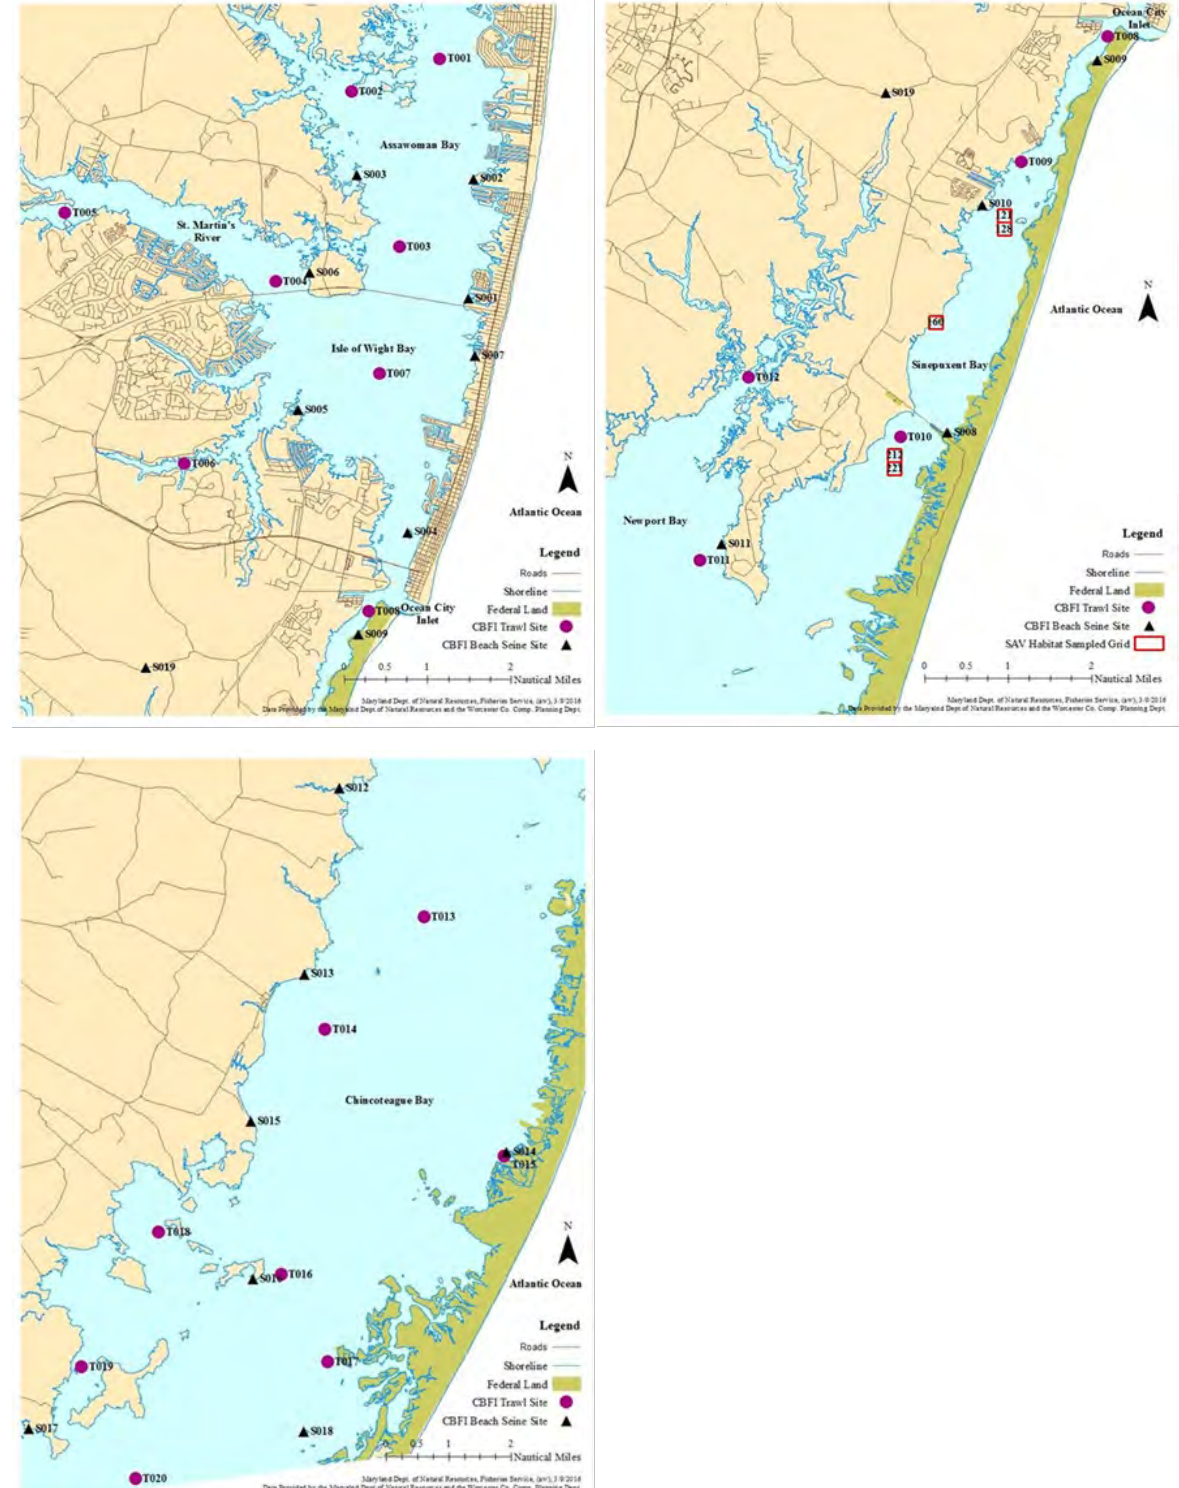
Figure 61. Map of the Maryland Coastal Bays Survey sampling sites. Trawl sites are labled with the prefix of “T” (map from MD